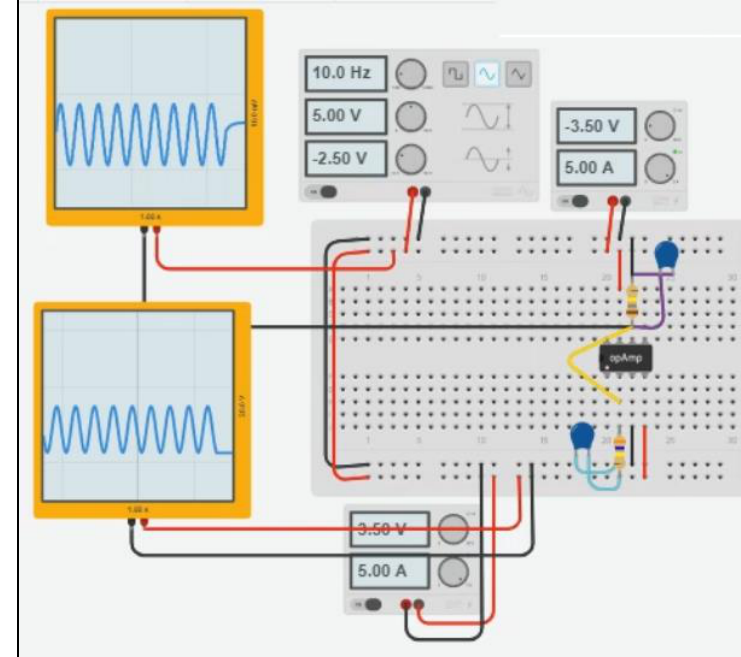
Figure 2: Lead Compensator using opamp circuit.